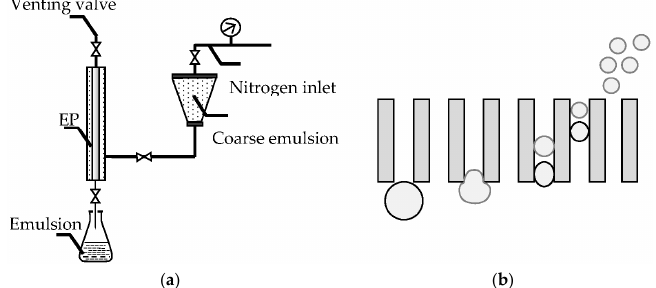
Figure 2. Schematic diagram of premix membrane emulsification apparatus and principle. ( a ) Premix membrane emulsification apparatus; ( b ) Premix membrane emulsification principle.